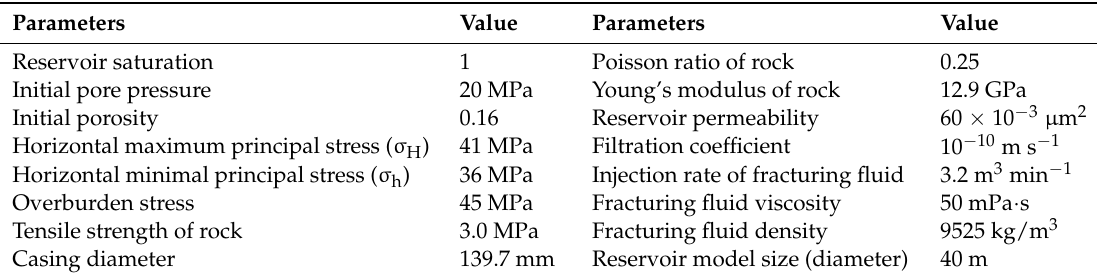
Table 1. Basic parameters of the X Well in the Shengli